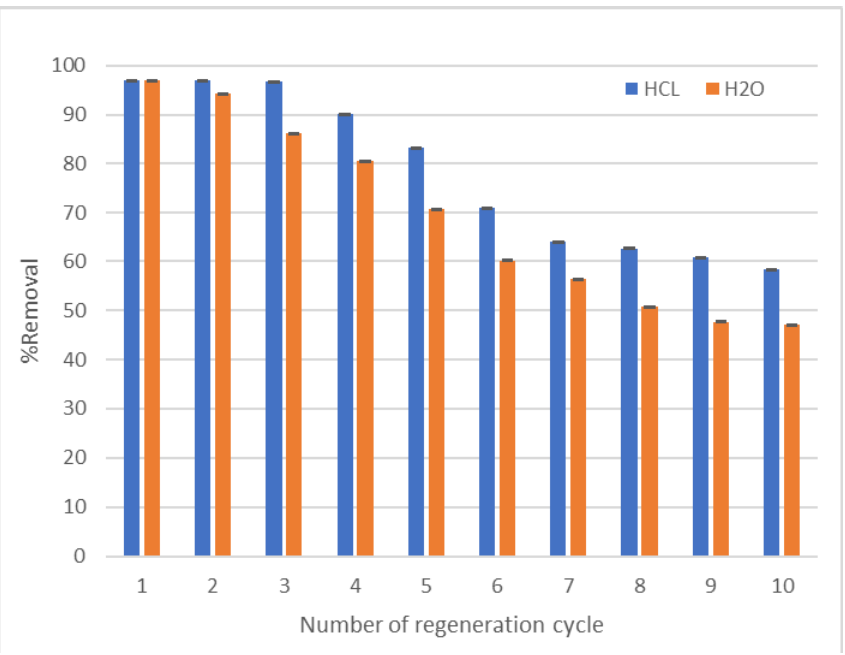
Figure 16. Reusability of LCF adsorbent (V = 25 mL, adsorbent weight = 0.05 g, pH = 7, agitation speed = 200 rpm, solution temperature = 25 °C, dye concentration = 10 ppm, adsorption time = 6 min and desorption time = 30 min).